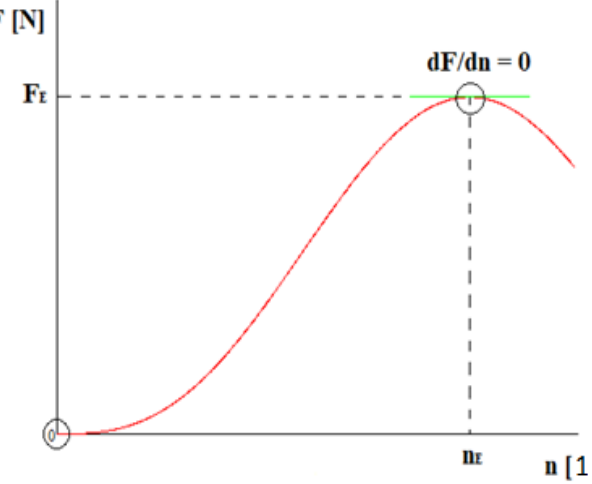
Figure 15. Boundary conditions of approximations.